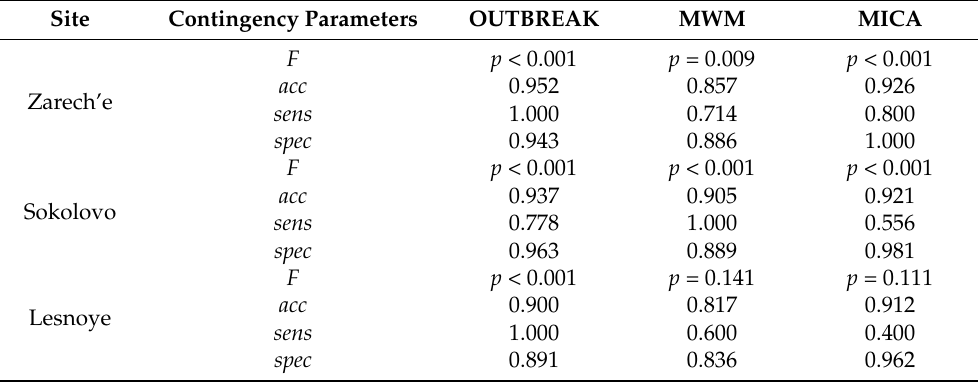
Table 5. Optimal values of function arguments used for B. piniaria outbreaks